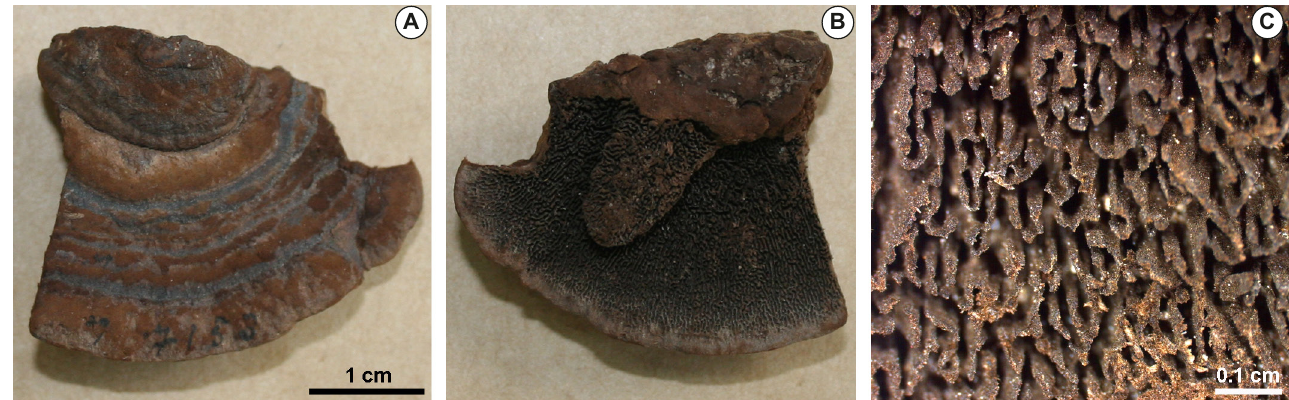
Nigrohydmun nigrum Figure 2. Macromorphological characters of (SP 33883): pilear surface (A), pore surface (B), detail of the pore surface